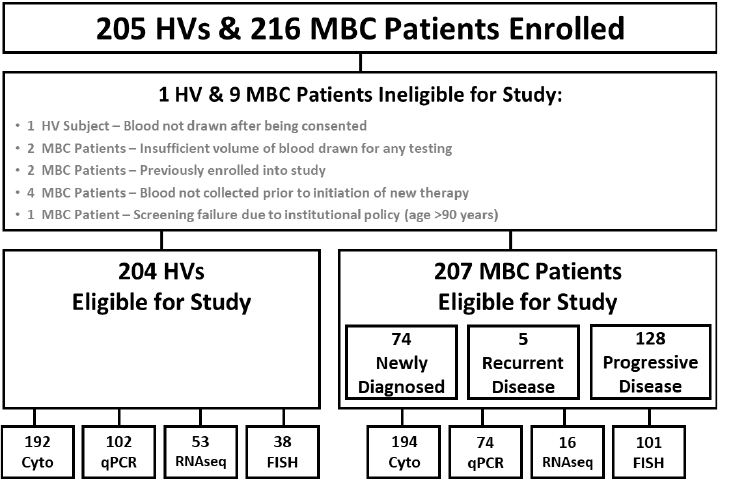
Figure 1. Study enrollment, eligibility, and evaluation. HV, healthy volunteer; MBC, metastatic breast cancer; Cyto, cytology evaluation; qPCR, quantitative polymerase chain reaction; FISH, fluorescence in situ hybridization. Table 1. Summary of eligible MBC patients and HVs demographics and clinical characteristics.